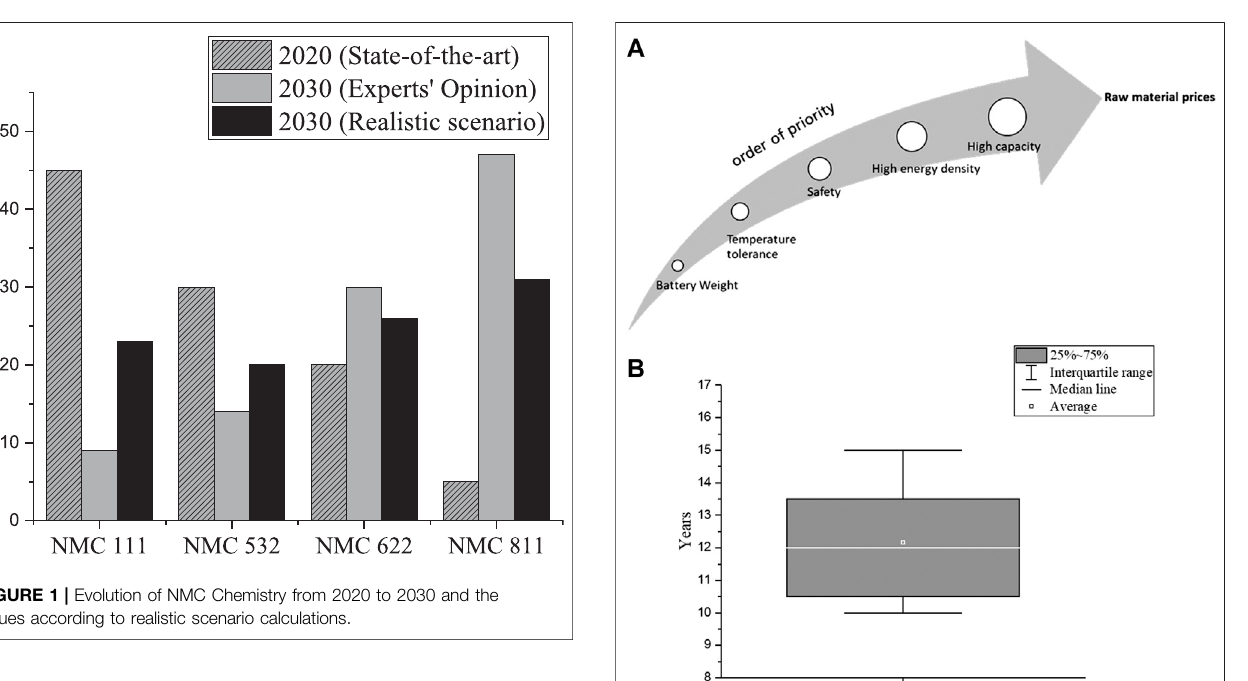
Frontiers in Energy Research |